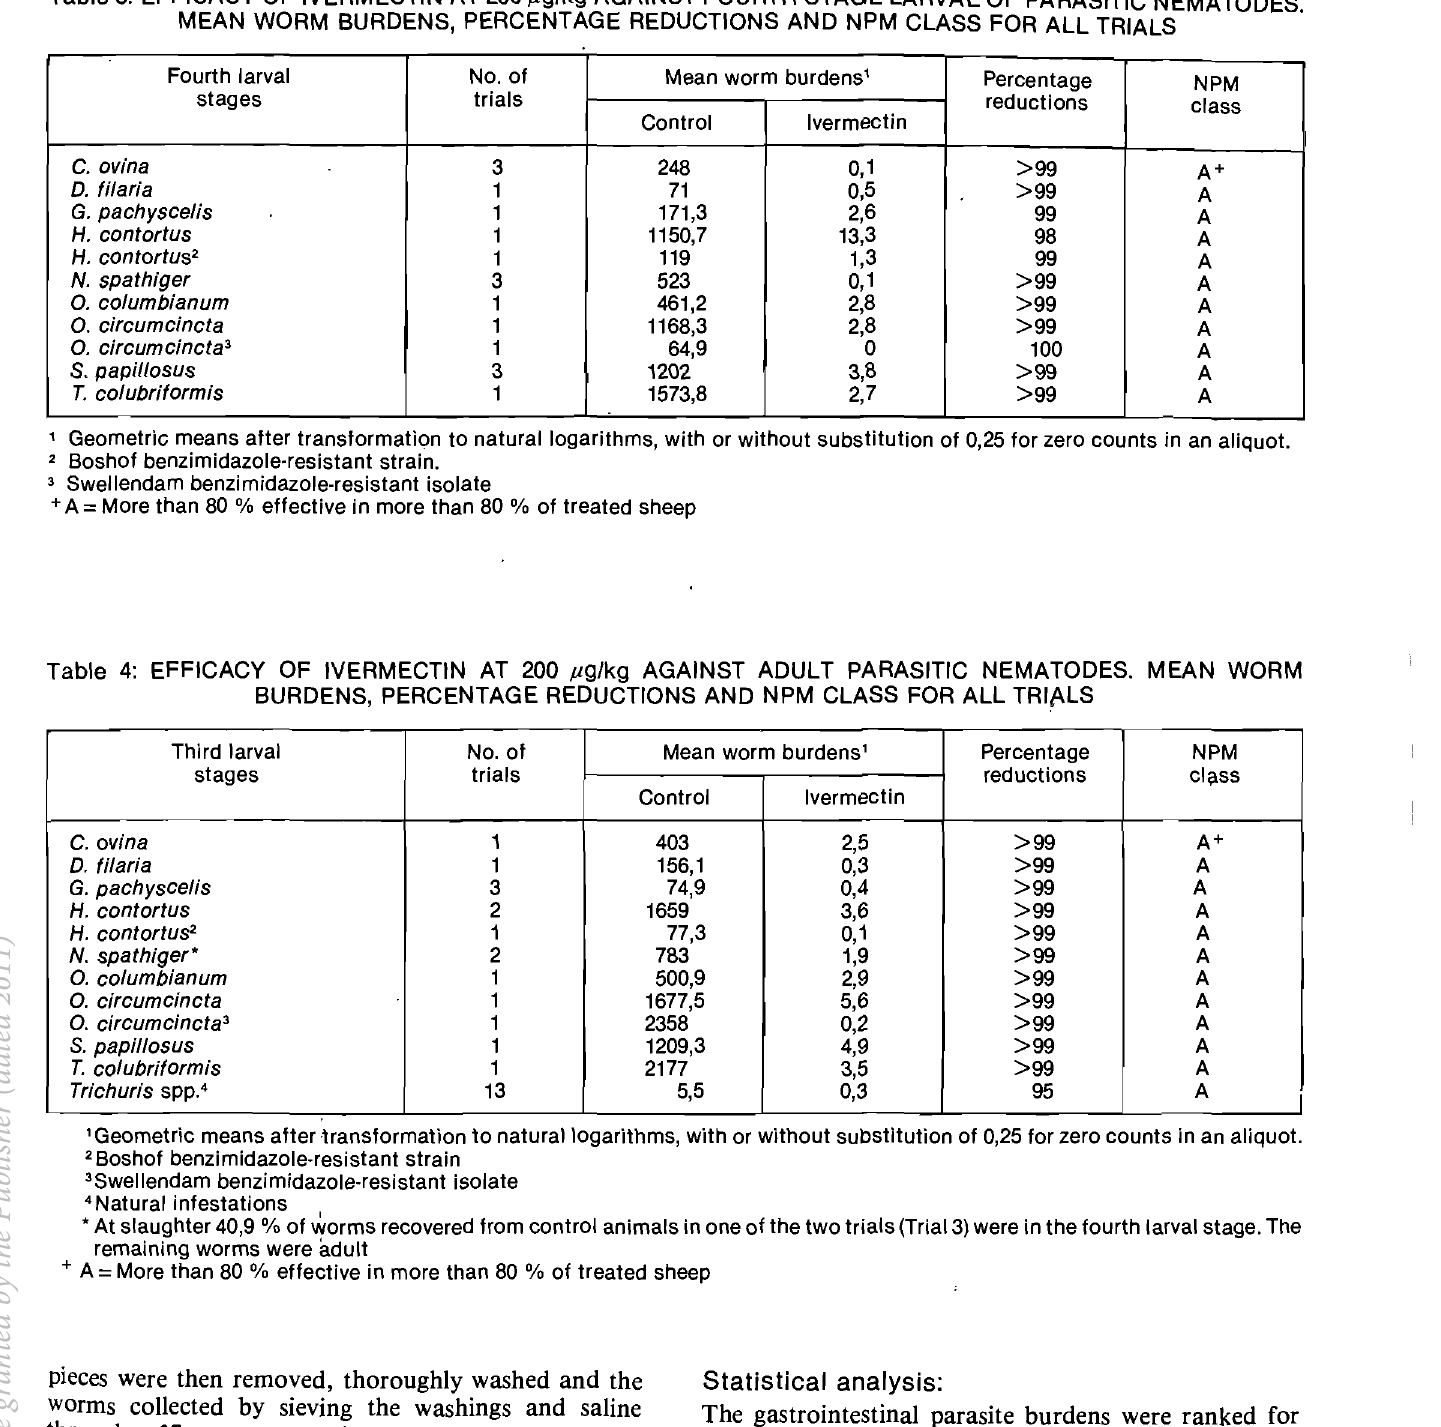
Table 3: EFFICACY OF IVERMECTIN AT 200 tlg/kg AGAINST FOURTH STAGE LARVAE OF PARASITIC NEMATODES. MEAN WORM BURDENS, PERCENTAGE REDUCTIONS AND NPM CLASS FOR ALL TRIALS Fourth larval No. of